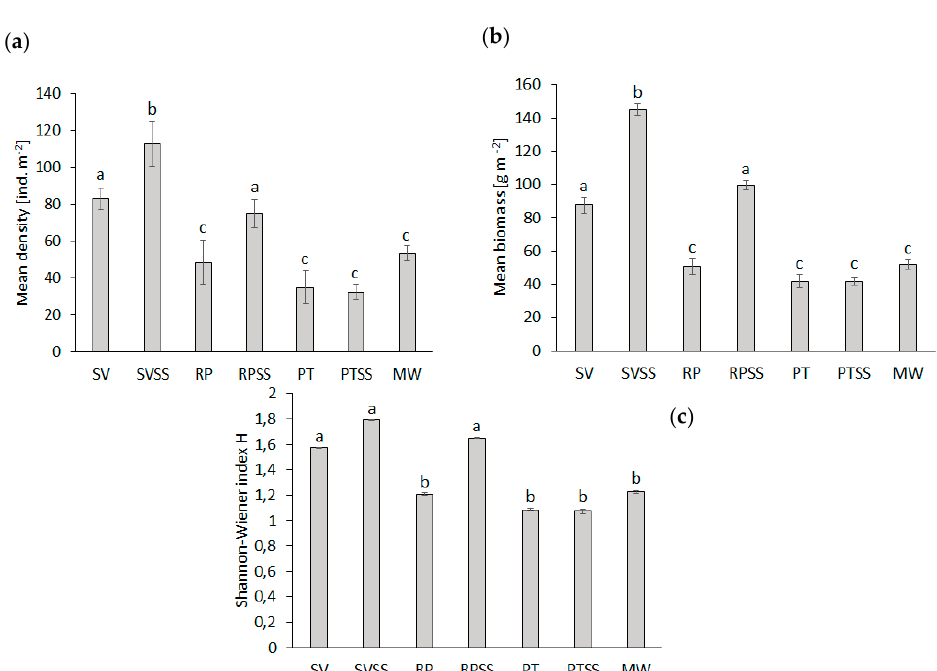
Figure 1. Bar plot of ( a ) the mean density of earthworms (ind. m − 2 ); ( b ) mean biomass (g m − 2 ); and ( c ) Shannon ‒ Wiener species richness index ( H’ ) per cultivation treatment with the standard error of the mean (SEM) as error bars. Bars with different letters are significantly different at p < 0.05 (N = 45). (Abbreviations of cultivation treatments are as given in Table 1).